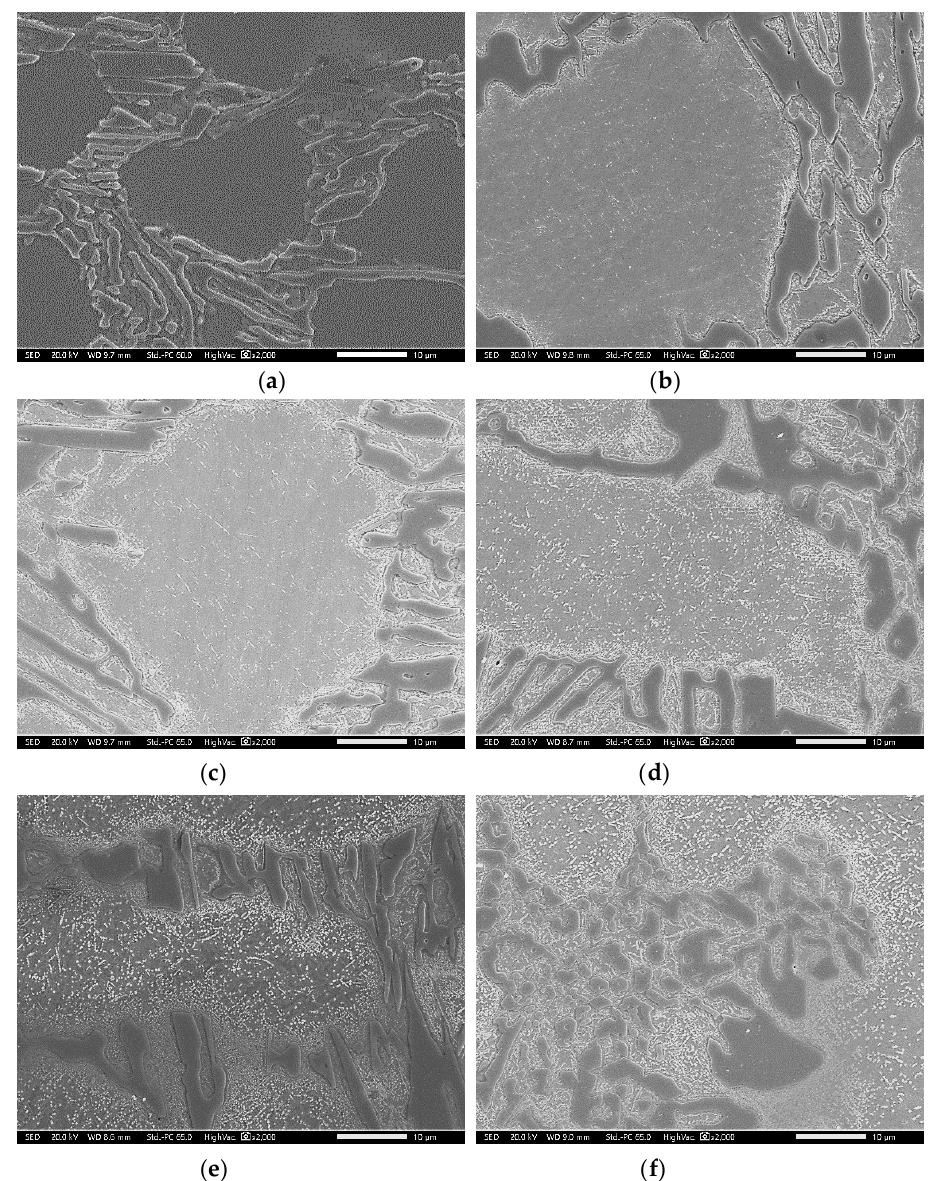
Figure 12. Effect of soaking time at 850 °C on the microstructural evolution of 2124 alloy: ( a ) as cast; ( b ) 10 min; ( c ) 30 min; ( d ) 60 min; ( e ) 240 min; ( f ) 300 min.